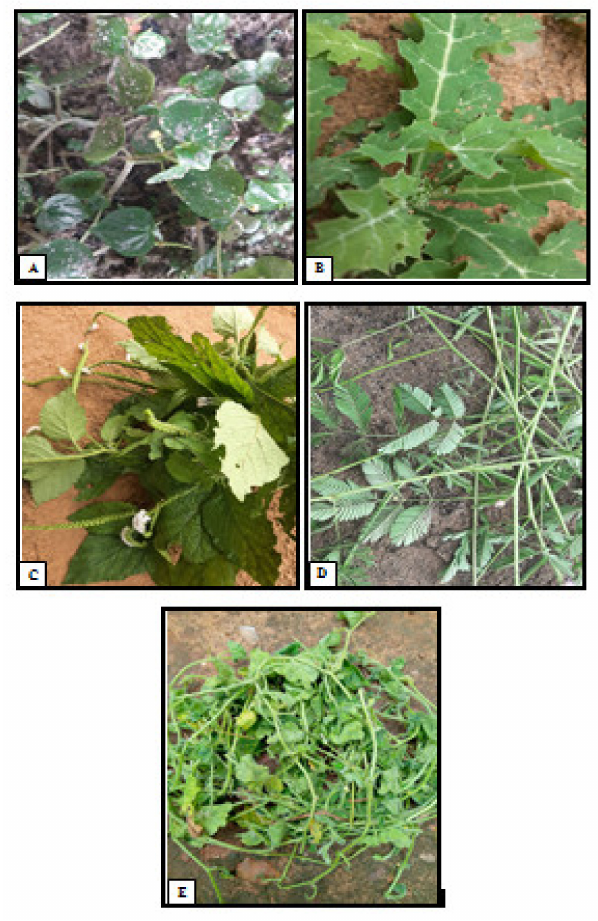
Figure 2. Photograph showing plant materials used in the study, ( A ) P. pellucida ( B ) A. mexicana ( C ) H. indicum ( D ) S. leptocarpa ( E ) K. foetidissima